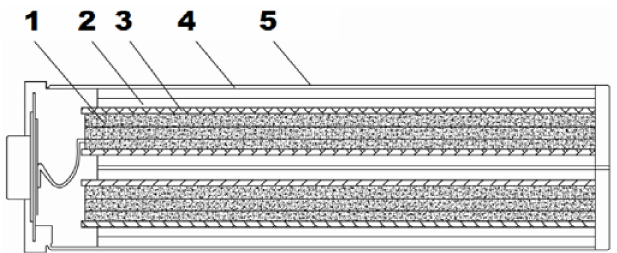
Figure 20. Schematic diagram of a high-capacity cell with 1: positive electrode (three layers), 2: negative electrode (three layers), 3: separator, 4: PTFE anti-corrosion film, and 5: can